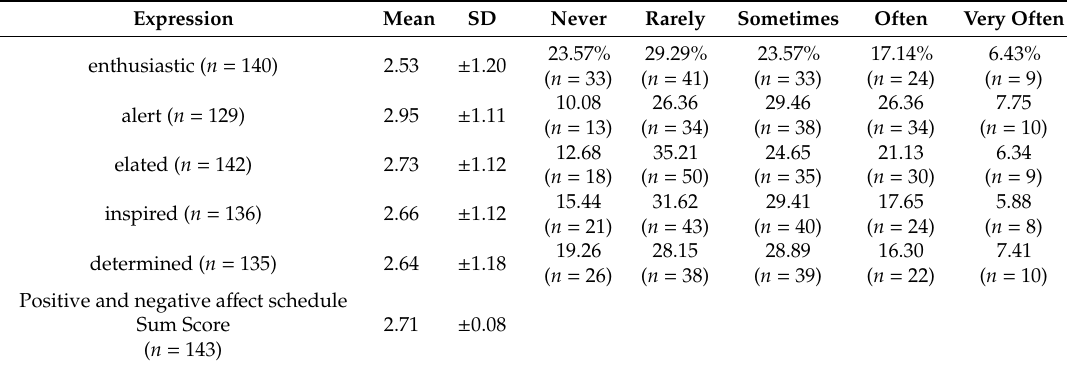
Table 2. Descriptive results concerning positive a ff ect of the residents.